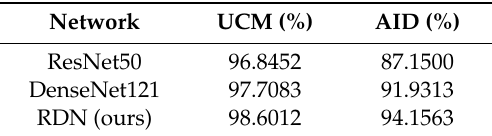
Table 2. Overall accuracy of ResNet50, DenseNet121 and RDN on the UC Merced Land-Use Dataset (UCM) and the Aerial Image Dataset (AID).